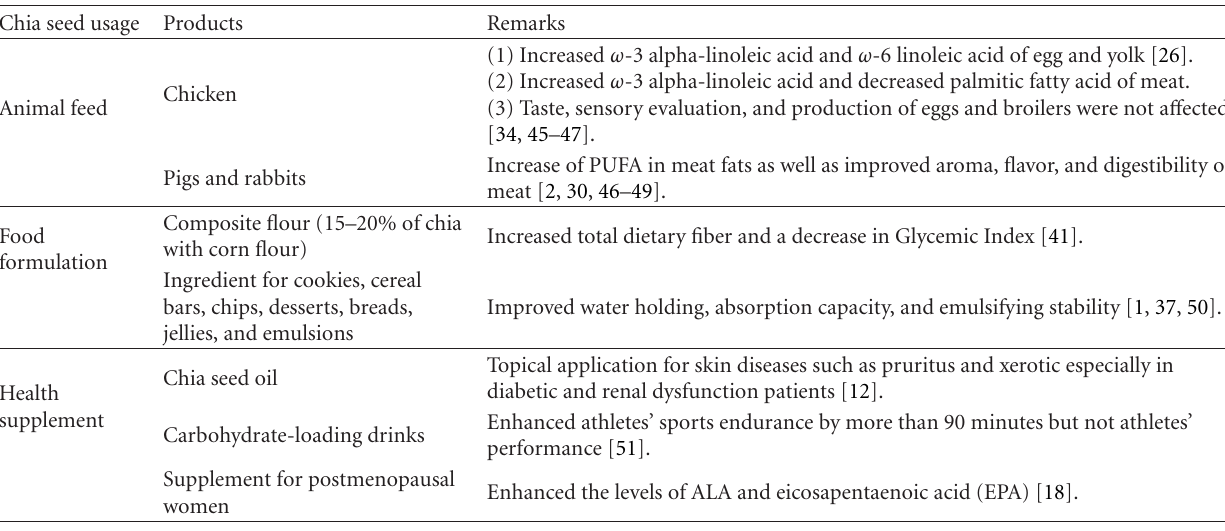
Table 4: Commercial usage of chia